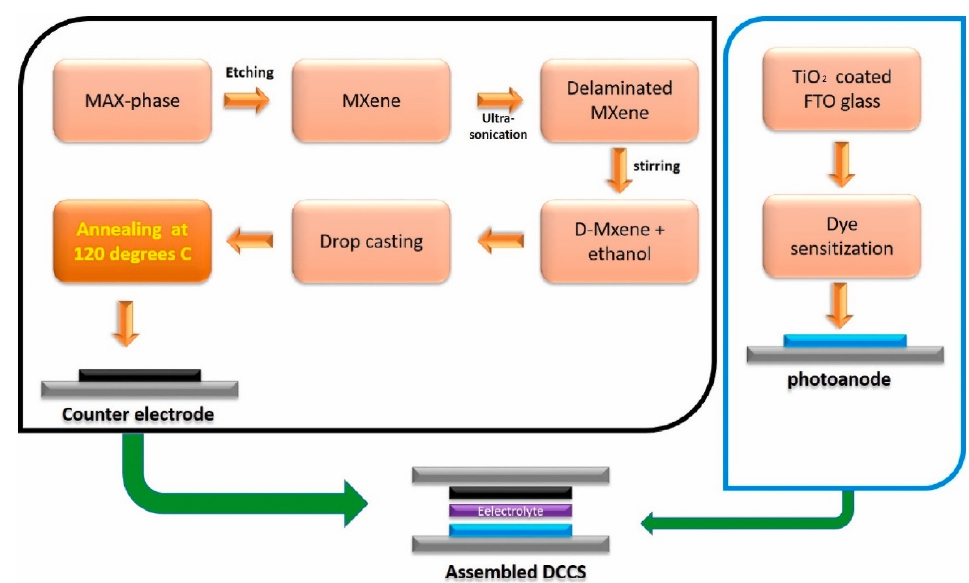
Figure 7. Schematic representation of an experimental procedure. Reprinted with permission from ref. [118]. Copyright 2021 Elsevier Ltd. and Techna Group S.r.l.